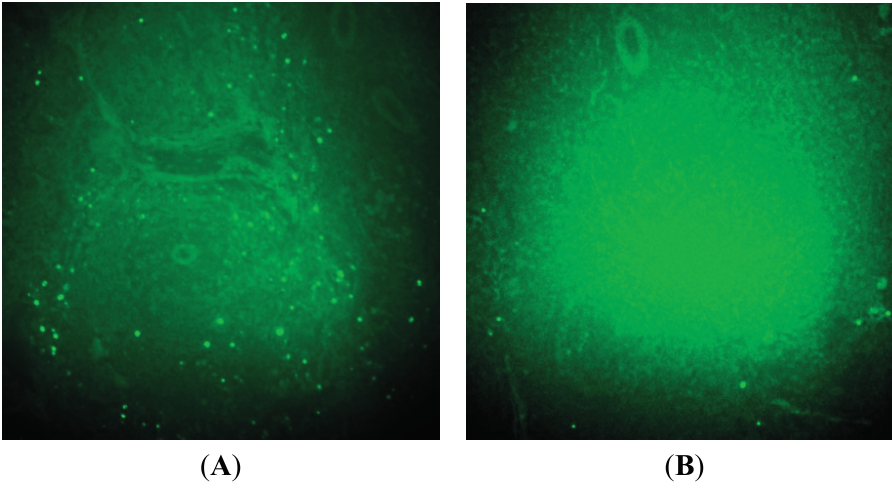
Figure 6. Representative TUNEL-stained images of liver specimen in CHX-treated rats ( A ), control rats ( B ). Green color dot represents positive TUNEL